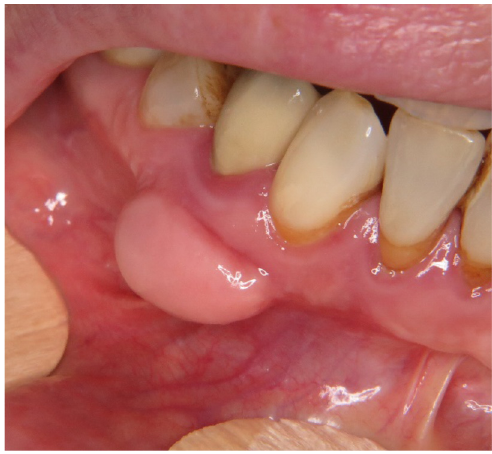
Fig. 1. Mandibular exostosis in place of an epithelia – conjunctive gingival